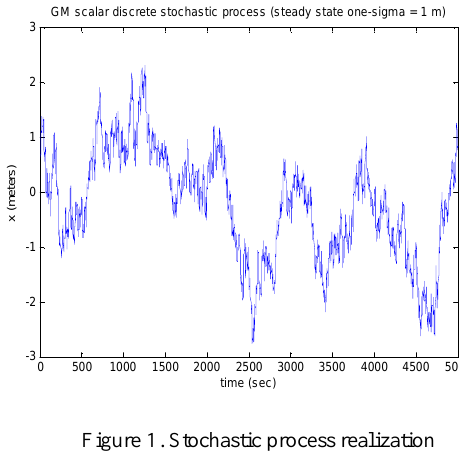
Figure 1. Stochastic process realization